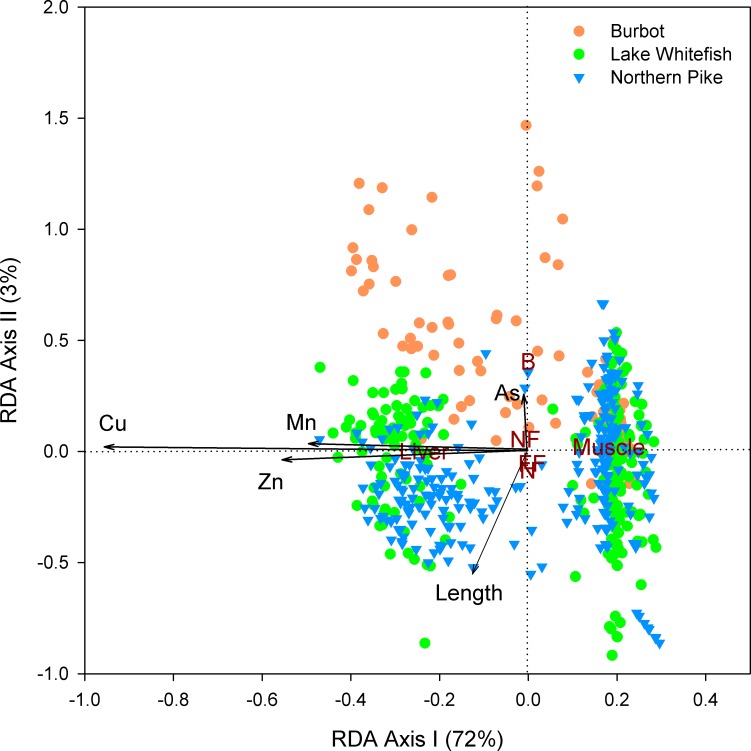
RDA correlation triplot of metal(loid)s in fishes of Great Slave Lake, Northwest Territories, Canada.Total concentrations of arsenic (As), copper (Cu), manganese (Mn) and zinc (Zn) are presented as a function of species (B = burbot, L = lake whitefish, N = northern pike), tissue type, capture area (NF = nearfield, FF = farfield), and fish length. The RDA model was highly significant (F = 360, p < 0.001, n = 572), and the first 2 canonical axes explained 75% of the variation of element concentrations in fishes.